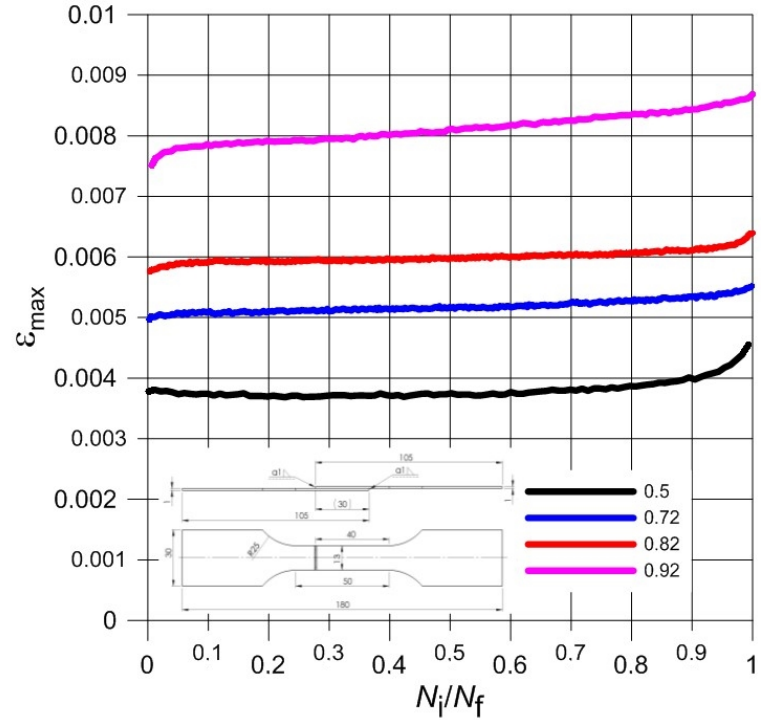
Figure 8. The course of maximum total strain during the fatigue load process of Type 3 samples.